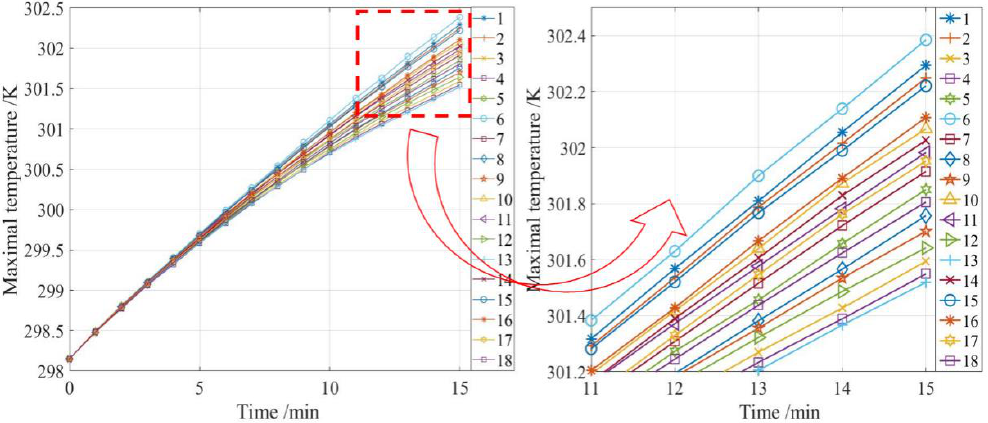
Figure 12. The MaxT variation in schemes for the battery pack with a single inlet and single outlet over time.